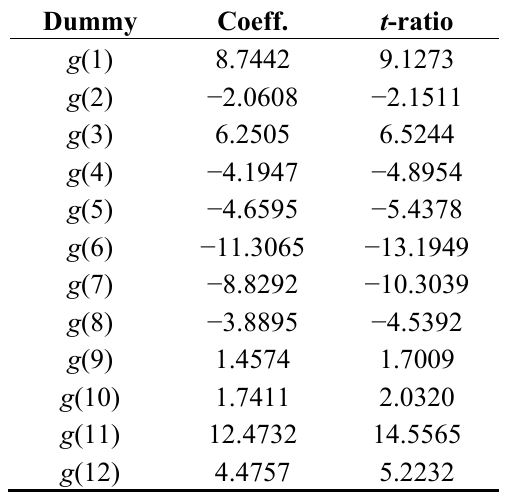
Table 3. Seasonal (OLS) estimates in wind load factor.